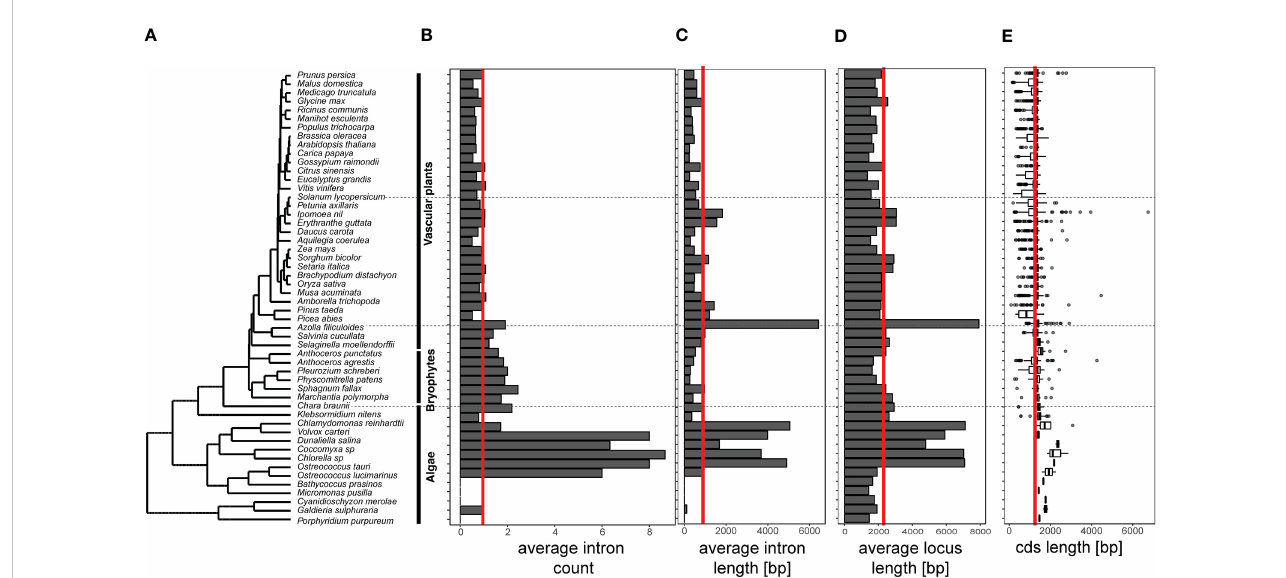
FIGURE 1 Genomic structure of BAHDs accross 52 representative genomes of plant species. (A) Representative species were selected from algal and land plant species and a species tree was inferred and illustrated as described in Kruse et al., 2022 and Moghe et al., 2023. Subsequently, we identi fi ed BAHDs using hmmsearch, estimated the number of introns per gene (B) , intron length (C) , locus length (D) , and coding sequence (cds) length (E) using custom Python scripts. The vertical red line indicates the average across all analyzed